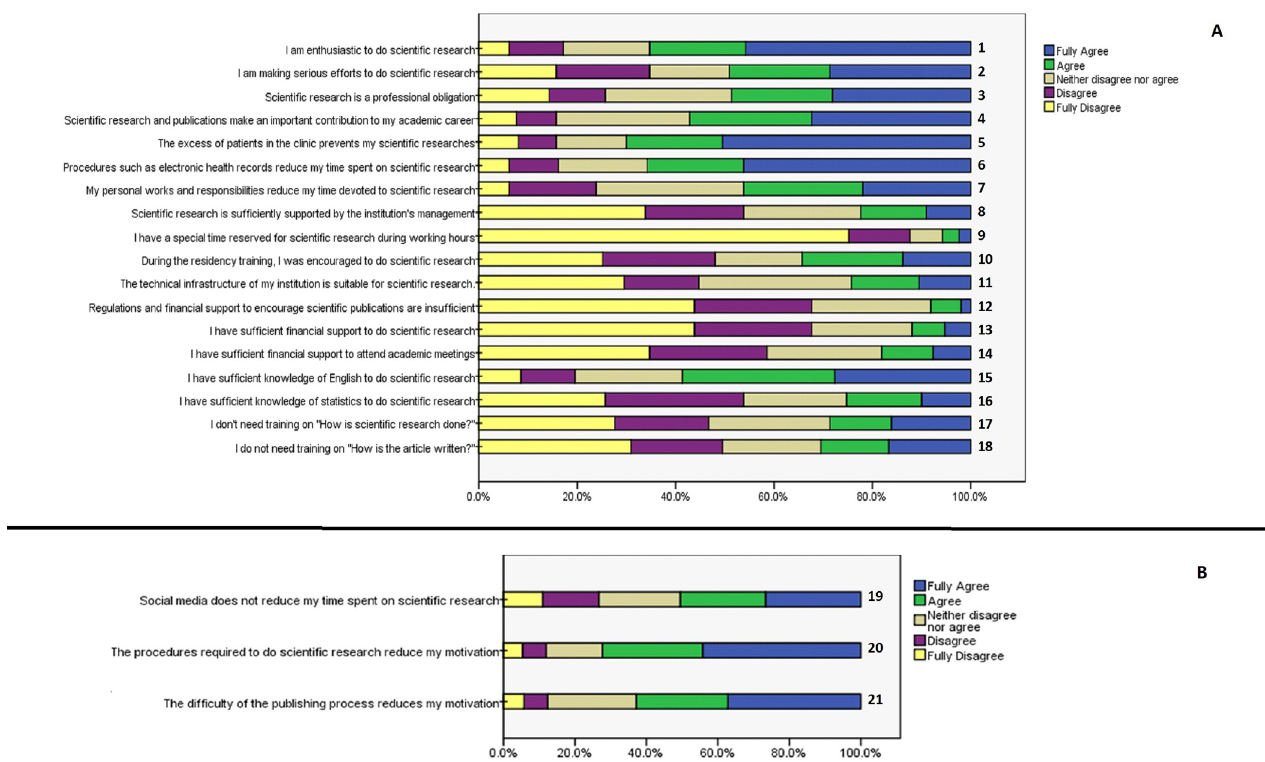
Fig 2. Likert bar graphs showing the distribution of the answers given by the participants to the questions. (A) Questions inside the scale after factor analysis. (B) Questions outside the scale. https://doi.org/10.1371/journal.pone.0273181.g002 The open-ended questions asked participants to list the three most motivating and most discouraging aspects of SR. Respondents stated that the strongest motivators were desire to contribute to science and make their mark, curiosity and desire to learn, and earning the pres- tige of academic titles. The most discouraging factors reported were clinical workload and excess of patients, insufficient technical infrastructure, and the general difficulties of research and publishing procedures, such as official approvals, from the beginning through to the final stages of a project. When we looked at research barriers by gender, we found no difference between men and women in terms of time constraints, research support, and competence (p = 0.853, p = 0.482, and p = 0.558, respectively). However, women are definitely more motivated than men to do